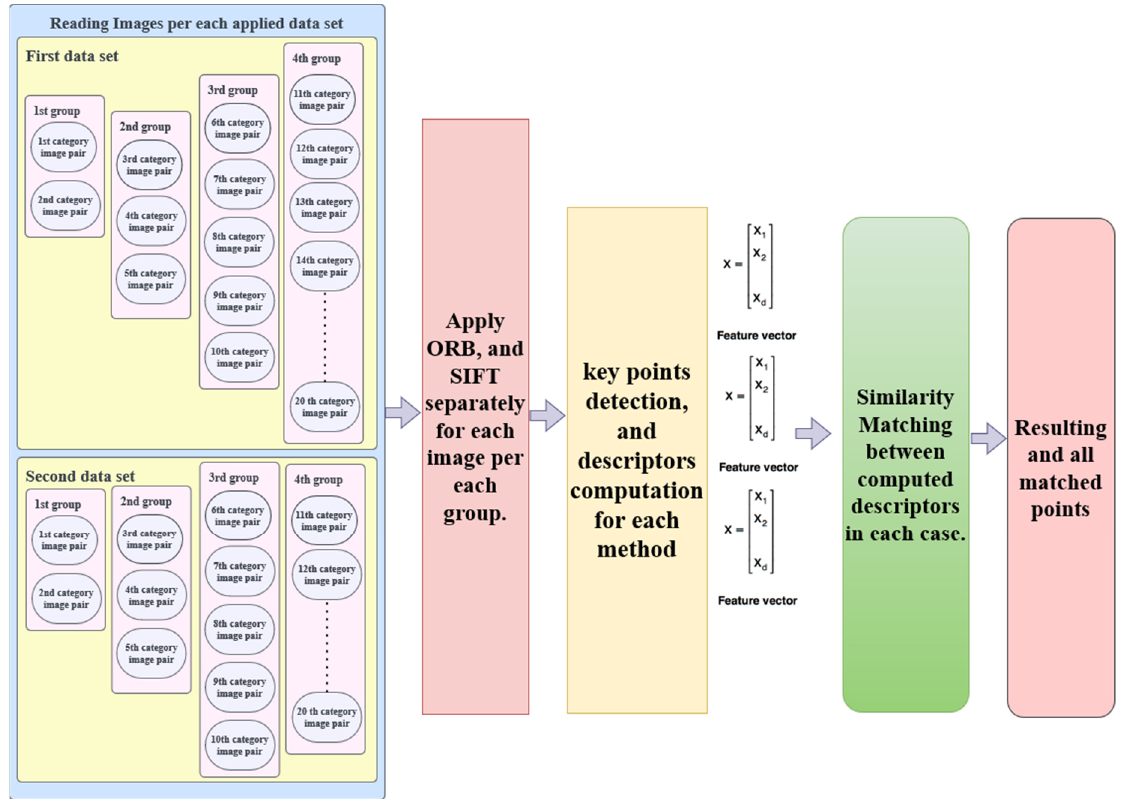
Figure 4. Experiment procedure flow diagram with handcrafted features.